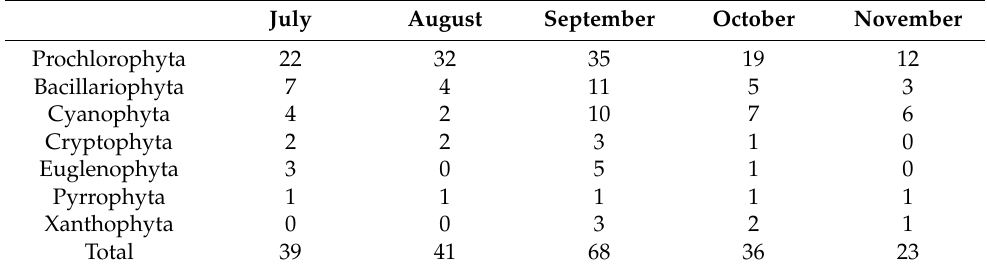
Table 3. Changes in phytoplankton phyla in the water around the artificial reefs.